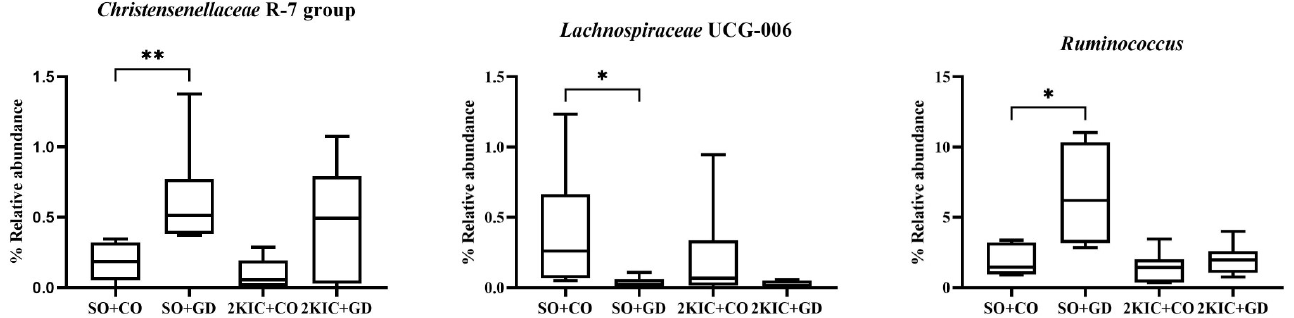
Figure 8. Alterations in gut microbiota composition at the genus level. SO, sham operation; CO, corn oil; 2K1C, 2-kidneys-1 clip; GD, Garcinia dulcis flower extract. * p < 0.05 and ** p < 0.01. Linear discriminant analysis (LDA) effect size (LEfSe) was used to identify